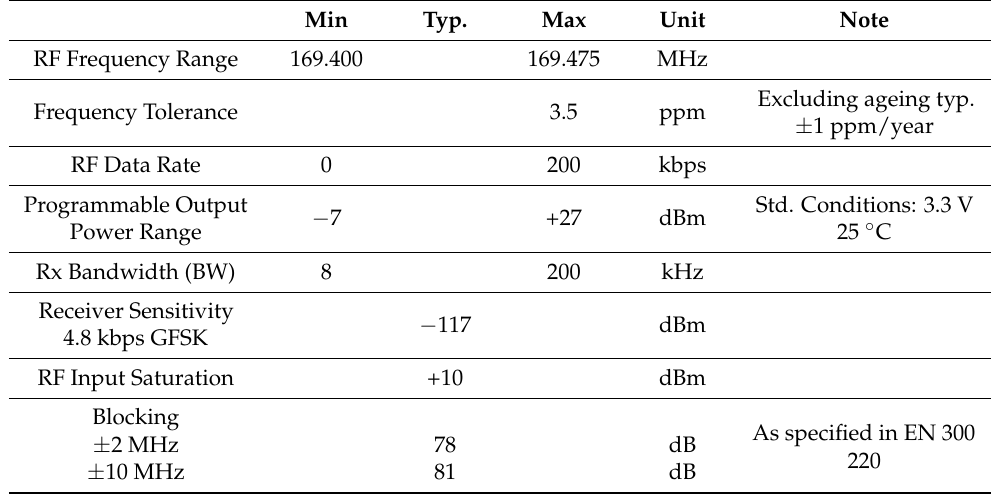
Table 1. EMB-WMB169PA RF Characteristics (Vcc = 3.3 V 25 ◦ C) [29]. Min Typ.